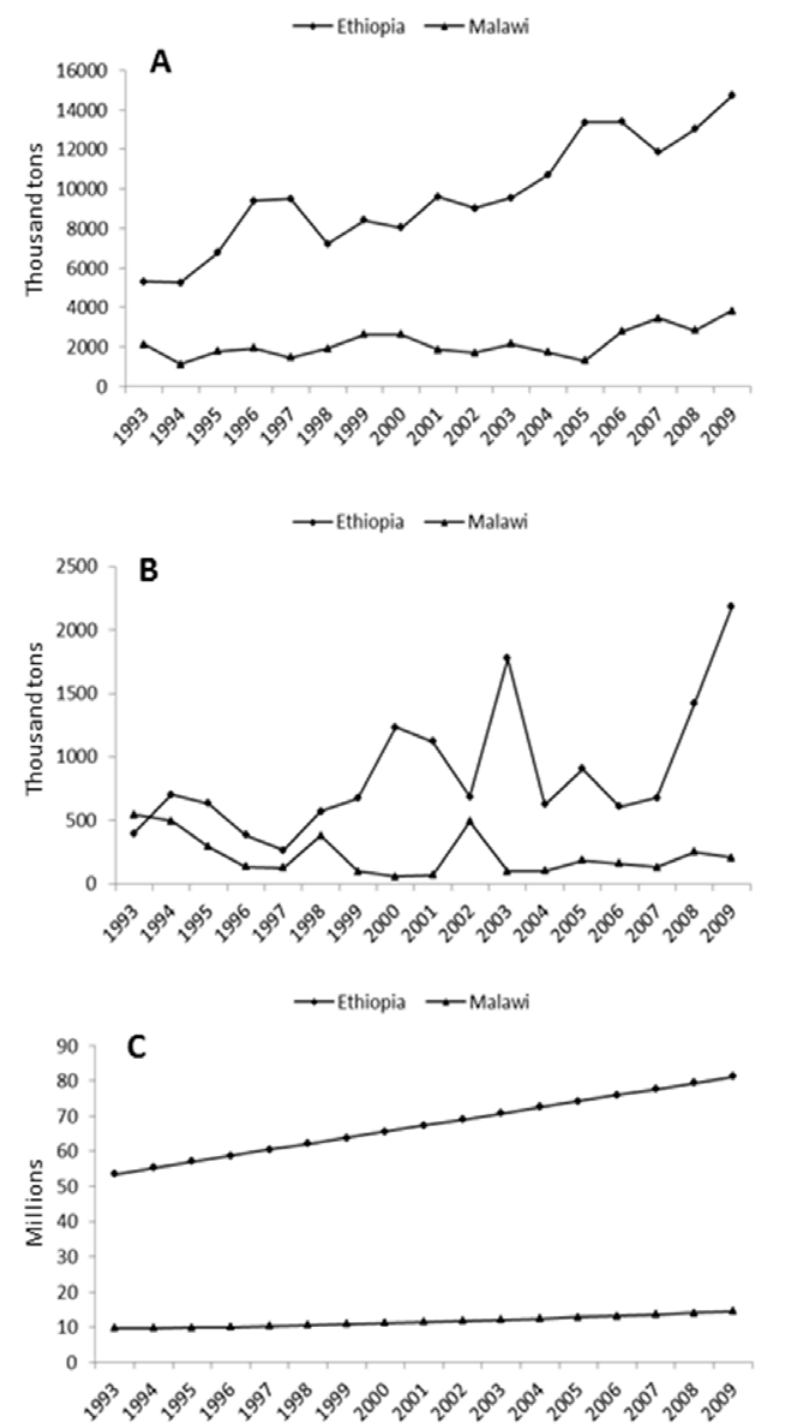
Figure 2. The total production and import of cereal crops and population growth in Ethiopia and Malawi from 1993 to 2009; ( A ) the total cereal production, which mainly constitutes tef, maize, wheat, and barley in Ethiopia and maize, paddy rice and wheat in Malawi (adapted from [32]); ( B ) the total cereal import for the two countries (adapted from [35]); ( C ) the total human population during the same period (adapted from